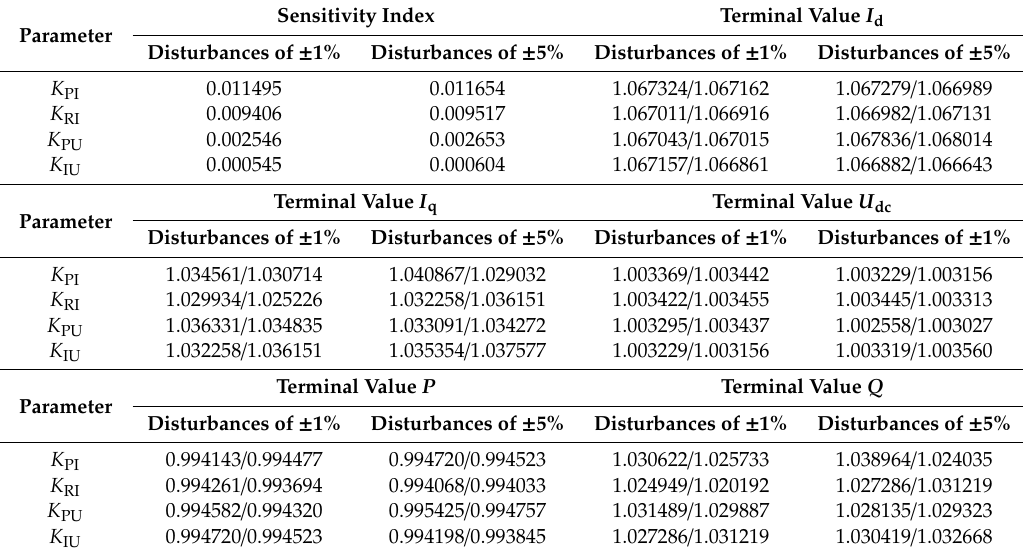
Figure 12. Dynamic response to perturbation of controller parameters: ( a ) Inner-loop parameters K PI ; ( b ) Inner-loop parameters K RI ; ( c ) Outer-loop parameters K PU ; ( d ) Outer-loop parameters K IU . Table 1. The result of the sensitivity analysis of parameter.